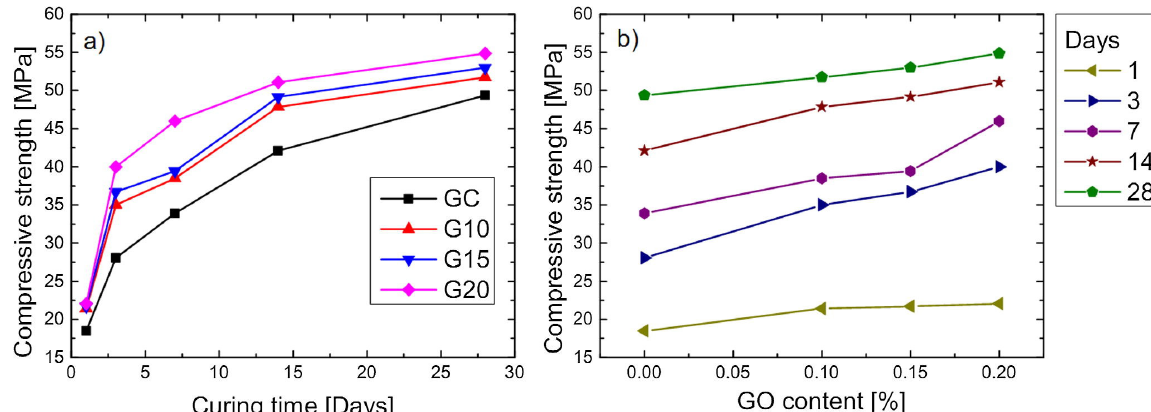
Figure 3: Compressive strength development of cement paste. (a) Effect of curing time on compressive strength of cement paste; and (b) effect of GO content on compressive strength of cement paste